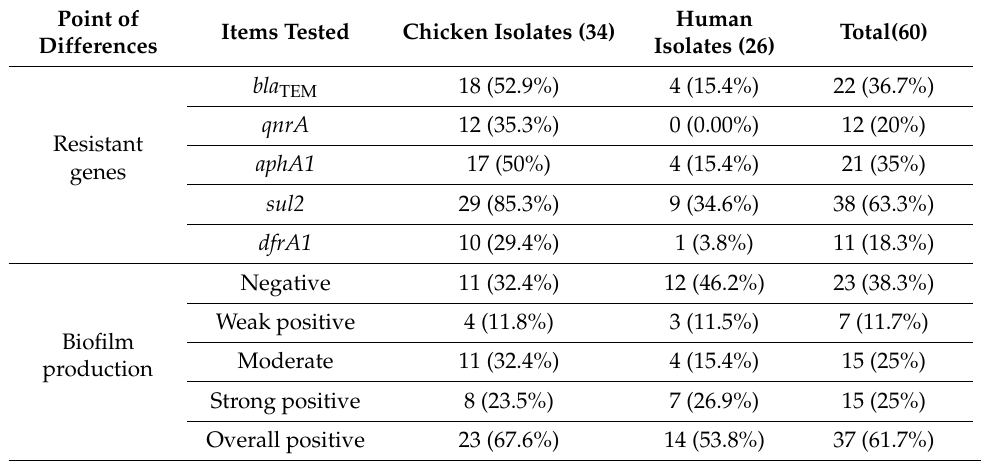
Table 6. Prevalence of antimicrobial resistance genes and biofilm production detected in E. coli